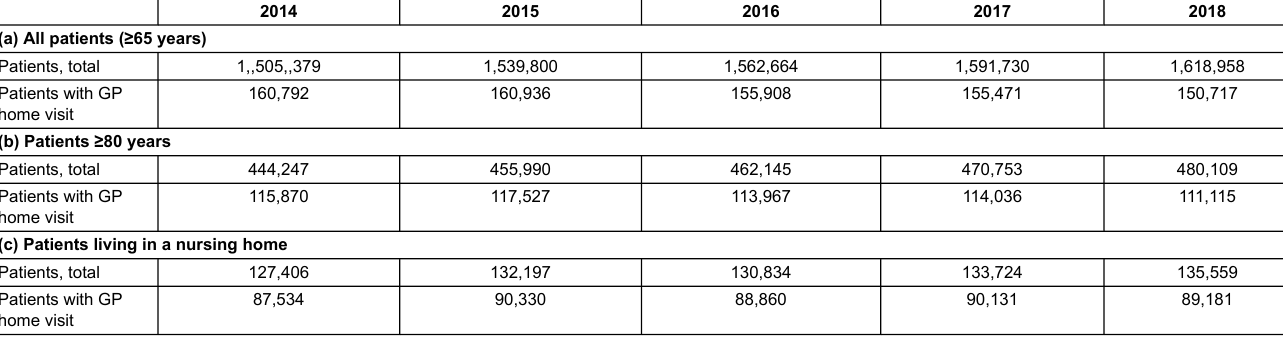
Table S3: Descriptive statistics of the raw data (Helsana sample) for patients without vs with at least one GP home visit during the entire observation period (2014–2018), for the entire population (≥65 years) as well as for the two subgroups including patients ≥80years and patients living in a nursing home. Without GP home visit With at least one GP home visit